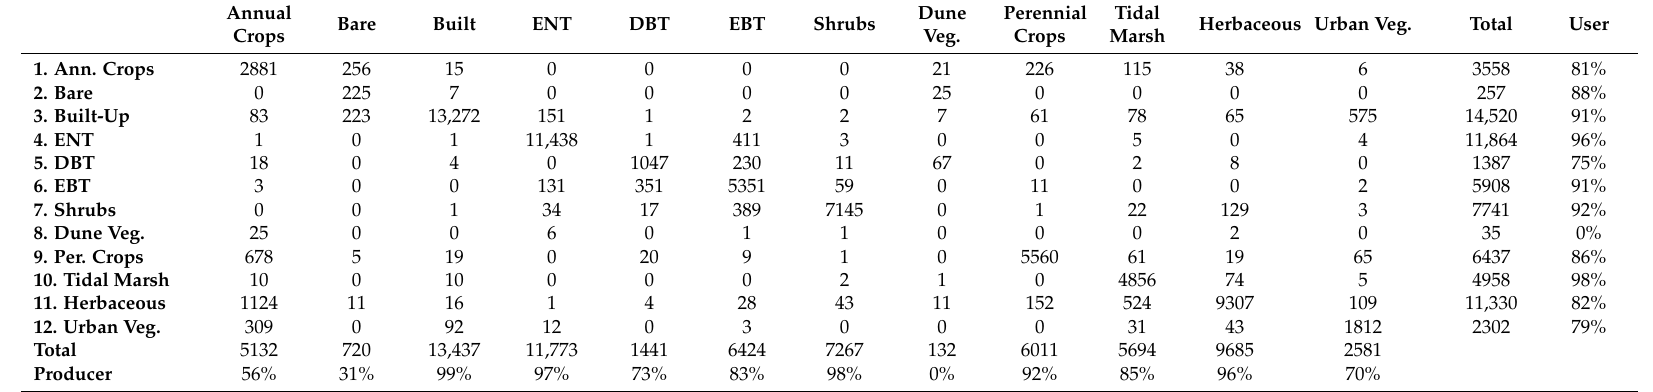
Table 4. SVM confusion matrix for the three-season